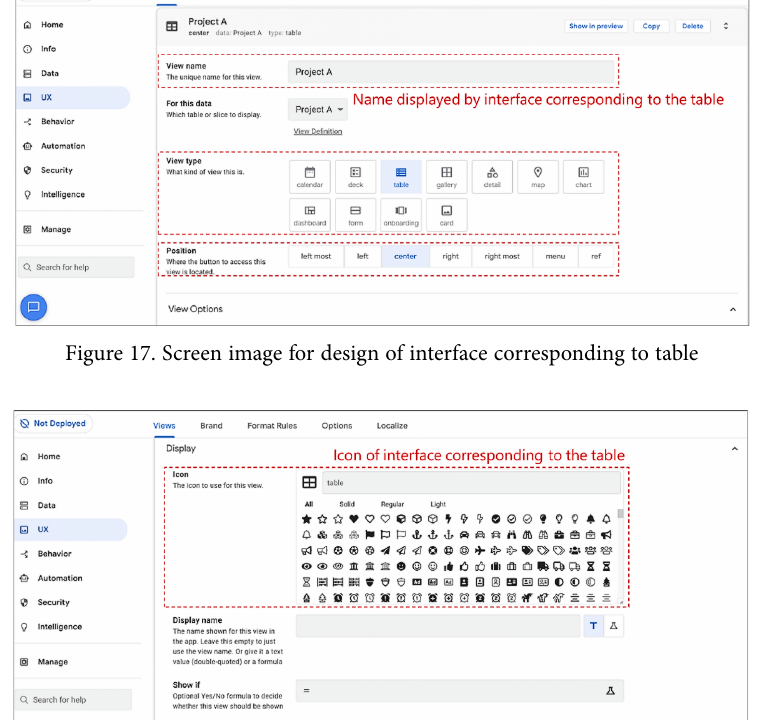
Figure 21. Sign-in screen image of app